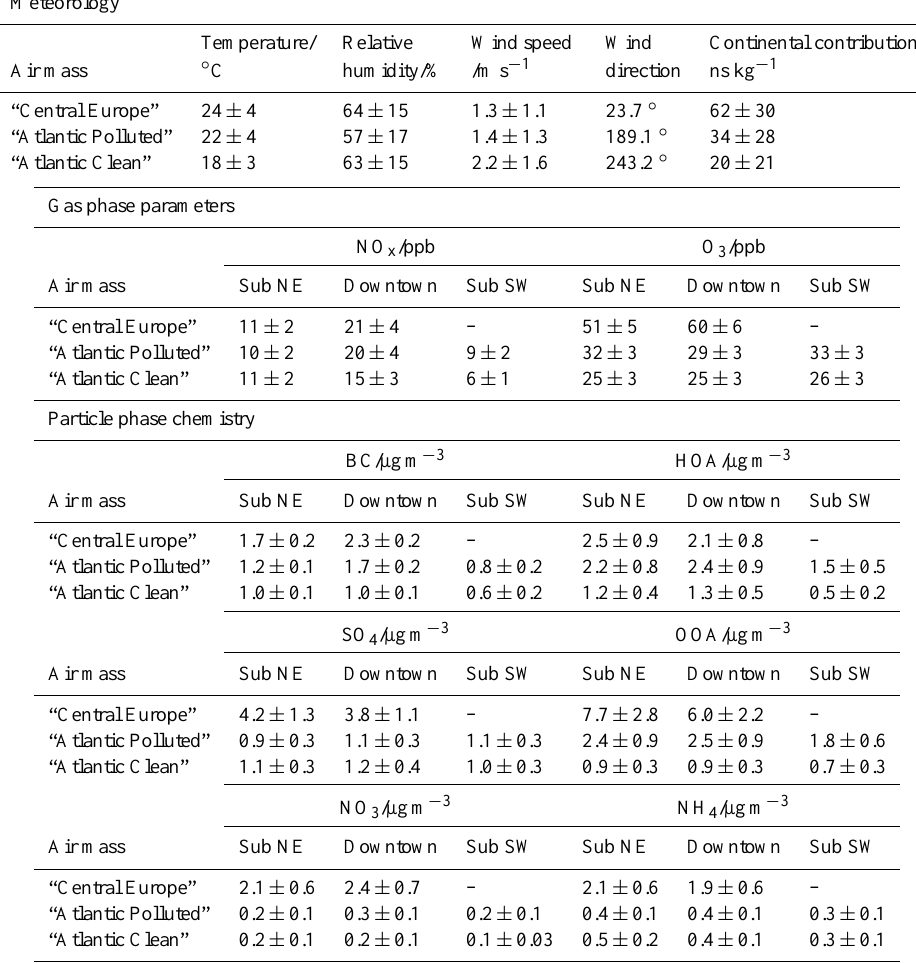
Table 3. Meteorological parameters measured at and modelled for Sub NE; gas phase parameters and particle chemical composition measured at the respective sites. Given are the averages with uncertainty ranges as deduced in Sect. 2, except for meteorological parameters, where means and standard deviations are provided. Chloride as measured by the AMS was below 0.1µgm − 3 at all sites for all averages and was therefore not regarded for this